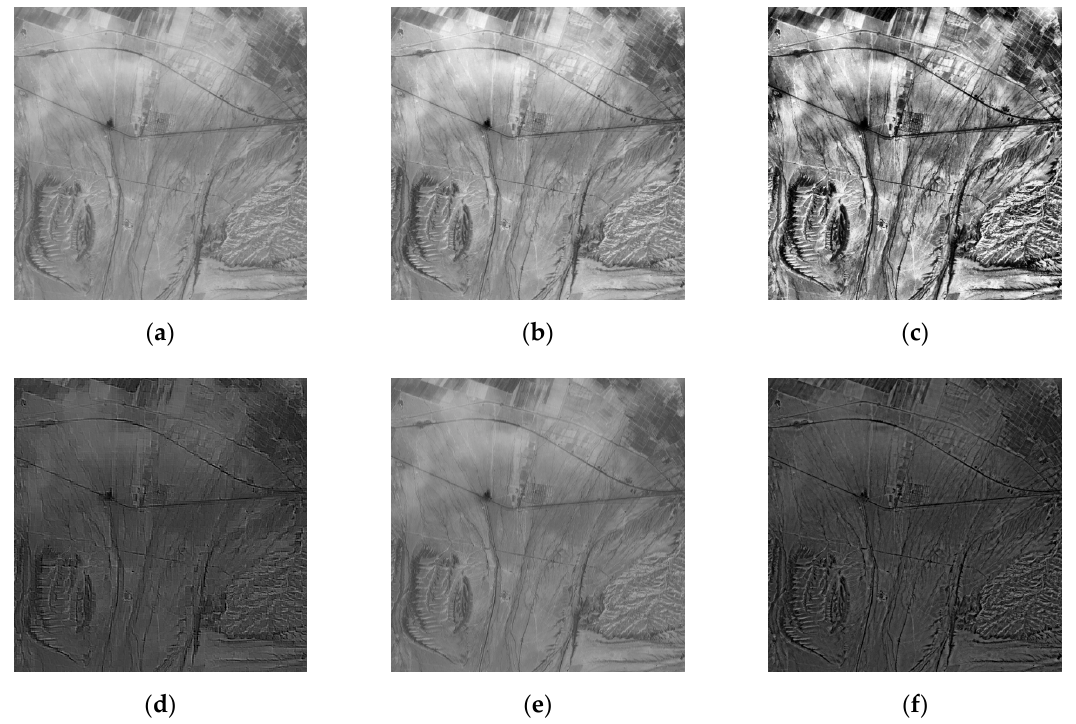
Figure 4. Comparison of different algorithms to clouds: ( a ) original image (artificial simulation to add clouds); ( b ) improved homomorphic filtering algorithm (IHF); ( c ) improved retinex algorithm (IR); ( d ) SWT + DWT algorithm (SD); ( e ) Mallat algorithm (M); ( f ) proposed method.